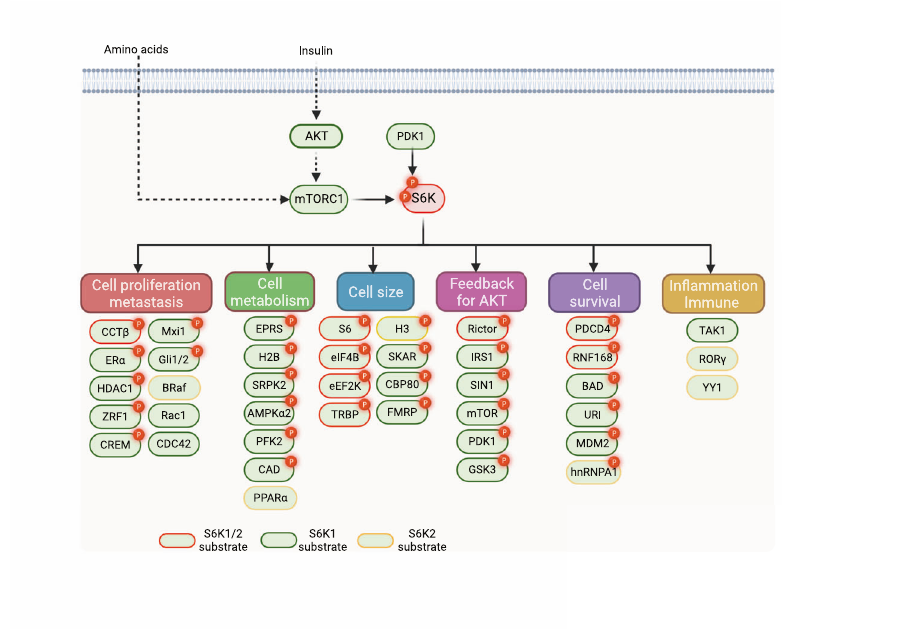
Fig. 3 Downstream substrates and effectors of S6K. After phosphorylation and activation by mTORC1 and PDK1, S6Ks function in dictating various physiological and pathological processes, including cell size control, metabolic homeostasis, survival, and metastasis, via a variety of downstream substrates in a phosphorylation-dependent or phosphorylation-independent manner. Although S6Ks hold several mutual substrates (labeled red), an increasing amount of evidence suggests that distinct functions are exerted by S6K1 (labeled green) and S6K2 (labeled orange), in part due to the minor difference in amino acid